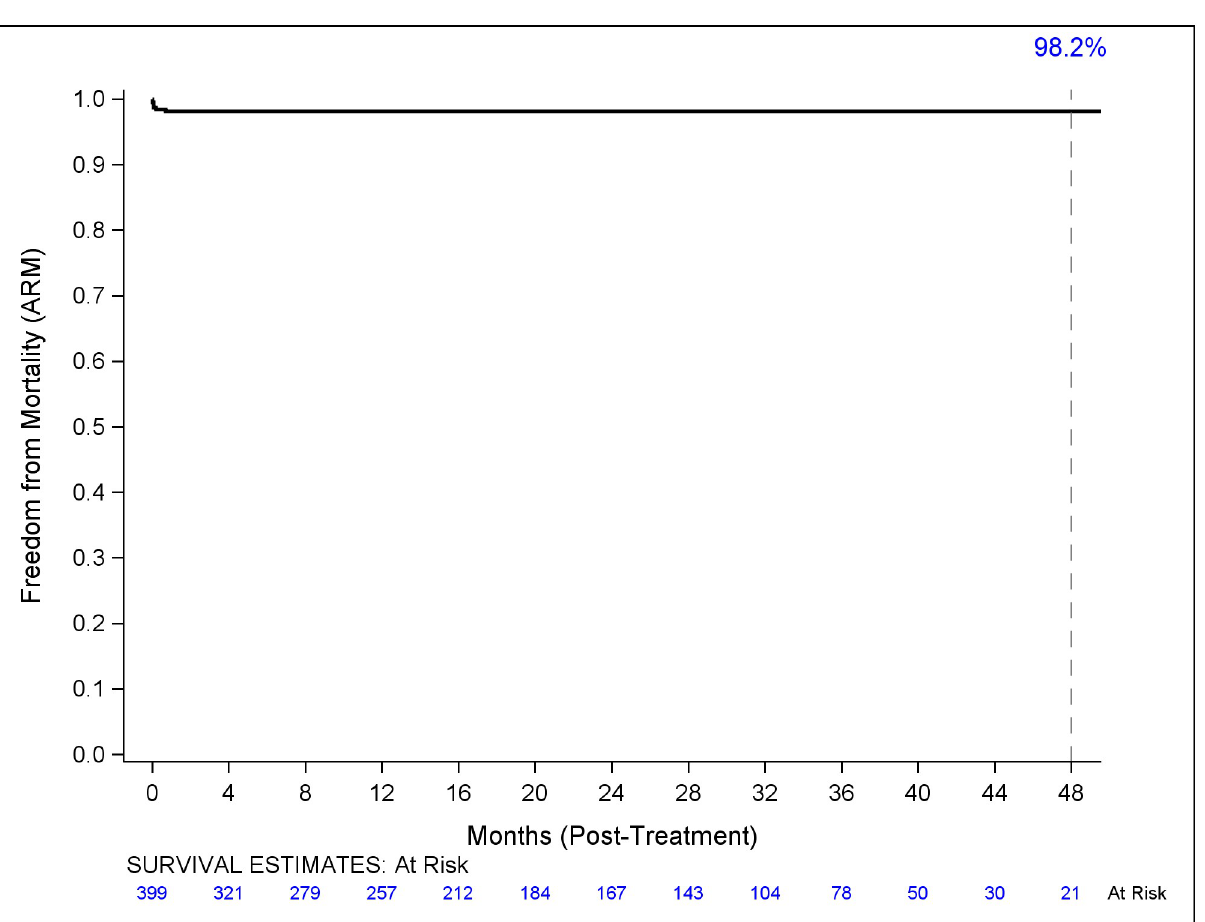
Fig 2. Freedom from aneurysm related mortality. Kaplan-Meier curve illustrating freedom from aneurysm-related mortality to 48 months. Numbers of patients at risk are presented on the x axis.